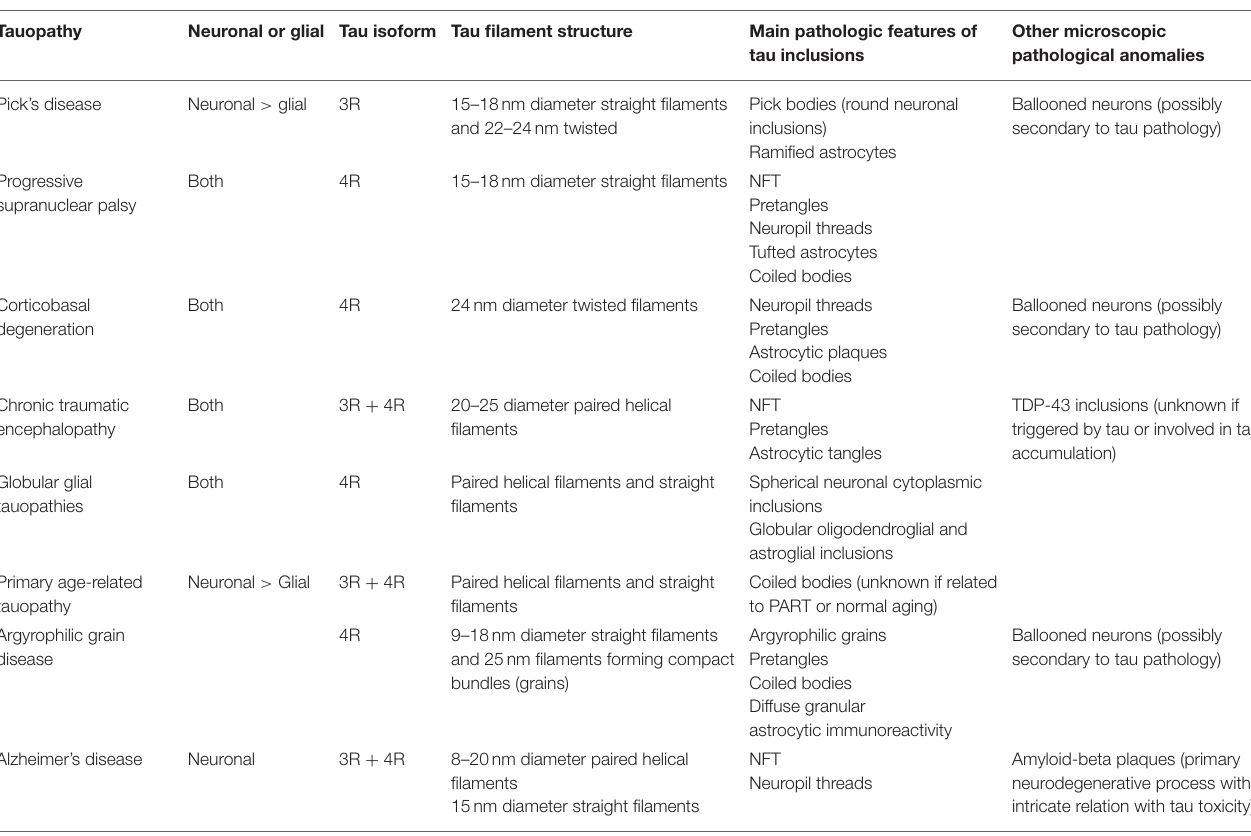
TABLE 1 | Pathological characteristics of